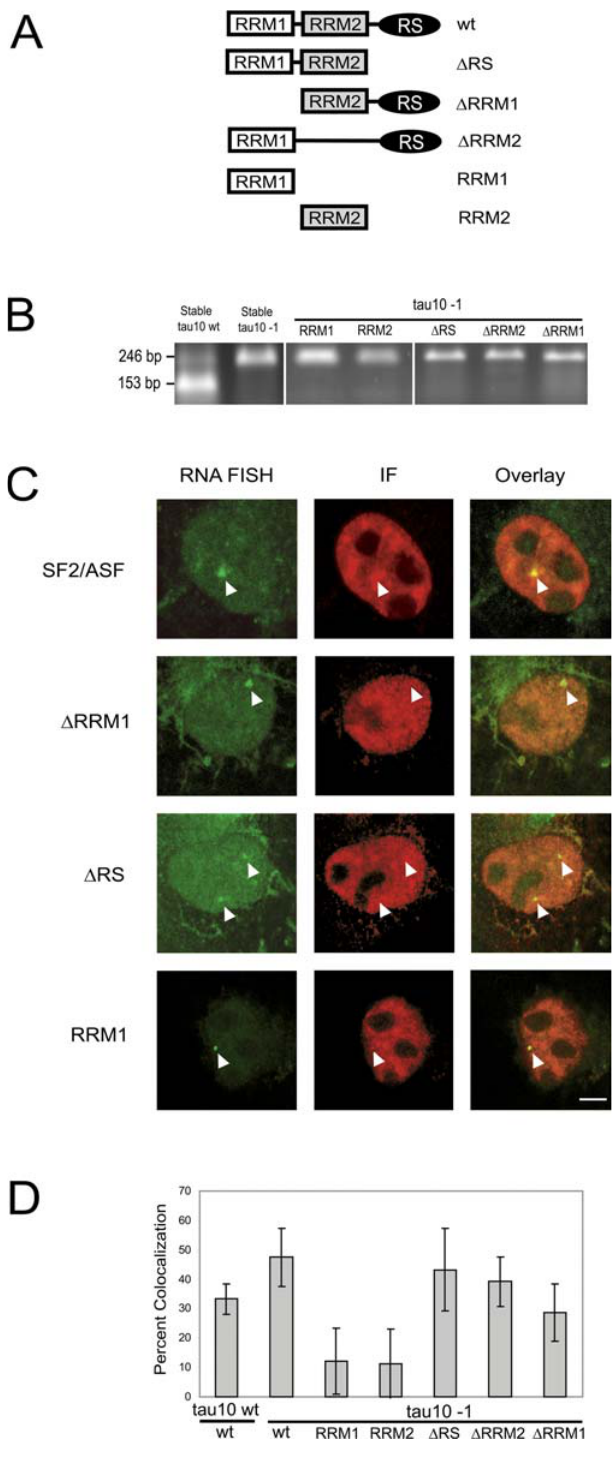
Figure 6. Deletion Mapping of Sf2/Asf Protein Domains Involved in Differential Recruitment (A) Schematic representation of T7-tagged mutants of SF2/ASF. (B) Semi-quantitative RT-PCR analysis of tau10 (cid:1) 1 splicing upon expression of mutant SF2/ASF. Overexpression of the mutant proteins does not affect tau splicing. (C) Recruitment of splicing factors to tau transcription sites detected by combined RNA-FISH using specific probes against the tau minigene (green) and IF microscopy with anti-T7 antibody (red). Arrowheads indicate tau transcription sites. Scale bar ¼ 2.5 l m. PLoS Biology |